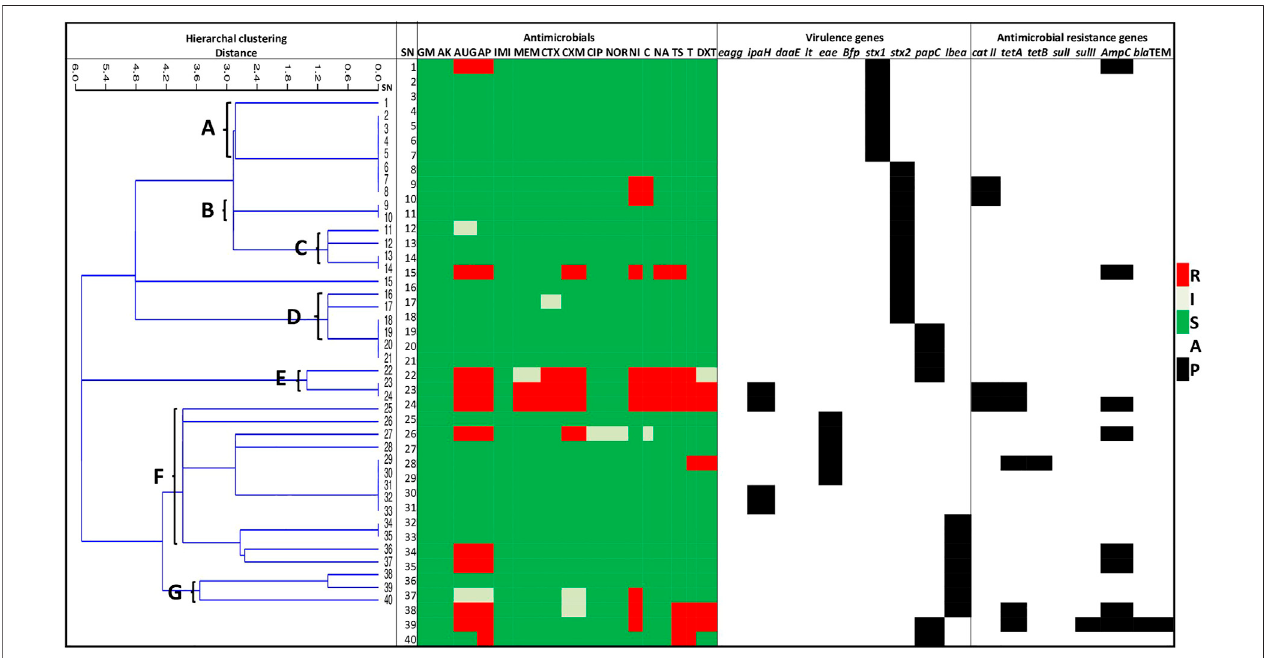
FIGURE 7 | A heatmap cluster analysis of the antibiogram pro fi les of the pathogenic strains of E. coli retrieved from agricultural soil samples. The clusters grouped related isolates into clades A to G based on their response/activity to the test antimicrobials. SN: Isolate numbers, R: Resistance, I: Intermediate, S: Susceptible, A: Absent, P: Present, GM-gentamycin, AK-amikacin, AUG-amoxycillin-clavulanic acid, AP-ampicillin, IMI-imipenem, MEM-meropenem, CTX-cefotaxime, CXM- cefuroxime, CIP-cipro fl oxacin, NOR-nor fl oxacin, NI-nitrofurantoin, C-chloramphenicol, NA-nalidixic acid, TS-trimethoprim/sulphamethoxazole, T-tetracycline,